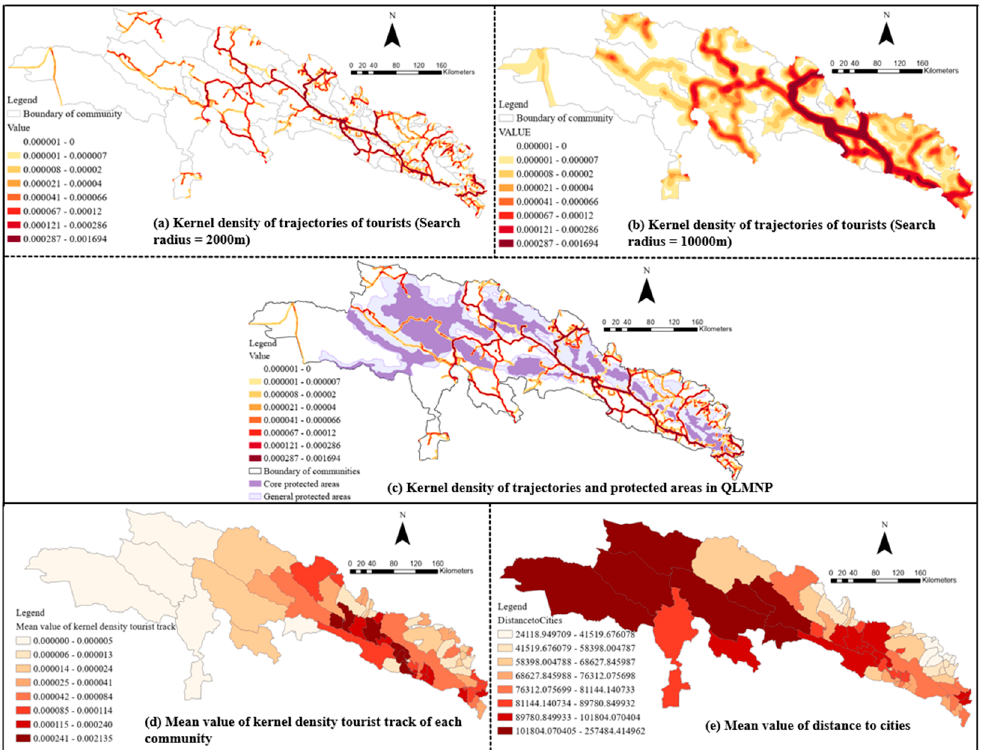
Figure 4. The spatial distributions of transportation and travel demand: ( a ) the kernel density of tourist routes (Search radius = 2000 m); ( b ) the kernel density of tourist routes (search radius = 10,000 m); ( c ) the kernel density of trajectories and protected areas in QLMNP; ( d ) the mean value of the kernel density of the tourist route of each community; ( e ) the mean value of the distance to large cities.